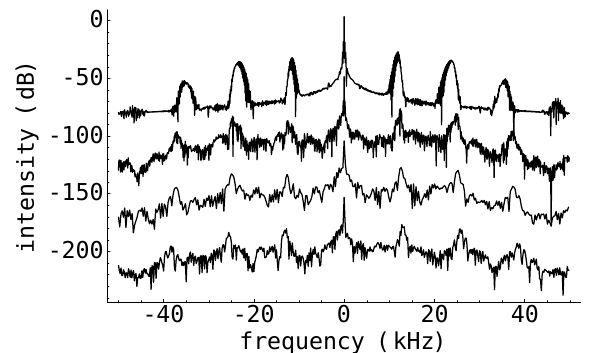
FIG. 19. Simulated spectra of 300 mA fully stretched unstable bunches propagating in a ring impedance consisting of main- cavity and harmonic-cavity fundamental rf modes and broadband impedances consisting of a Q (cid:1) 1.118 resonator with varying (cid:3) n j and resonant frequency 2.0 GHz. From top to bottom the j Z n traces have j Z n (cid:3) n j of 1.84, 2.32, 2.48, and 2.8 V . The frequency is offset from the 135th revolution harmonic. The tunes of the rf modes are realistically adjusted for beam-loading compensation. Successive traces are displaced 50 dB. Machine parameters are given in Table